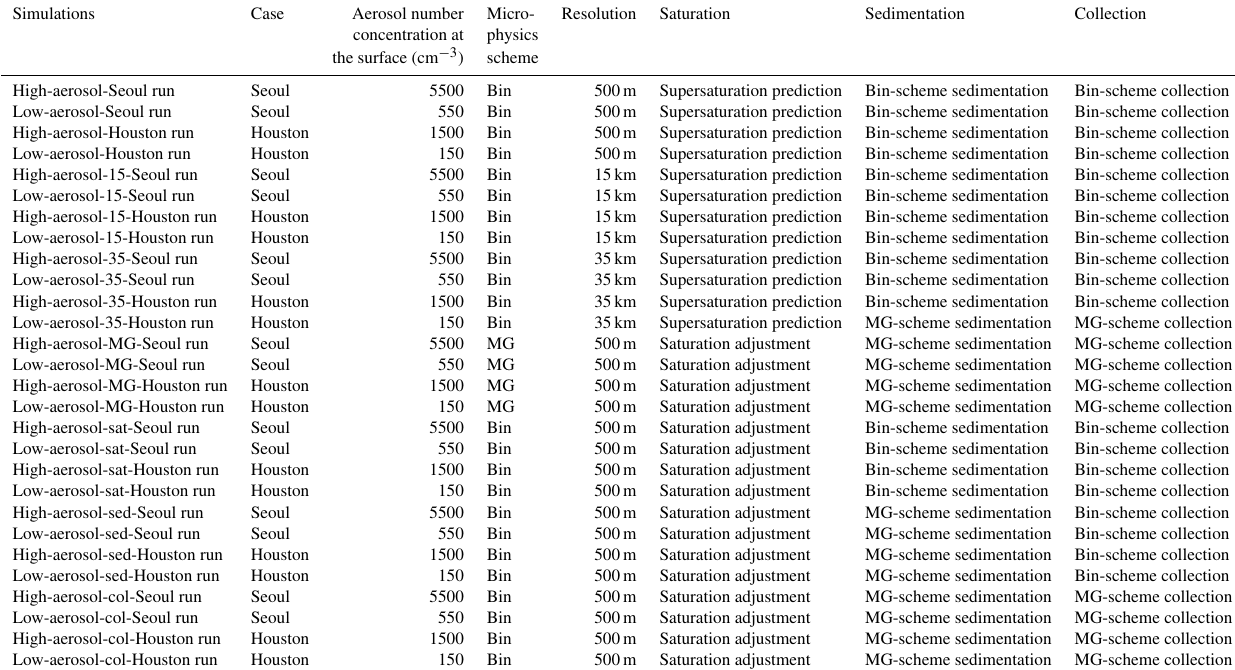
Table 1. Description of the simulations. Simulations Case Resolution Saturation Sedimentation Collection concentration at